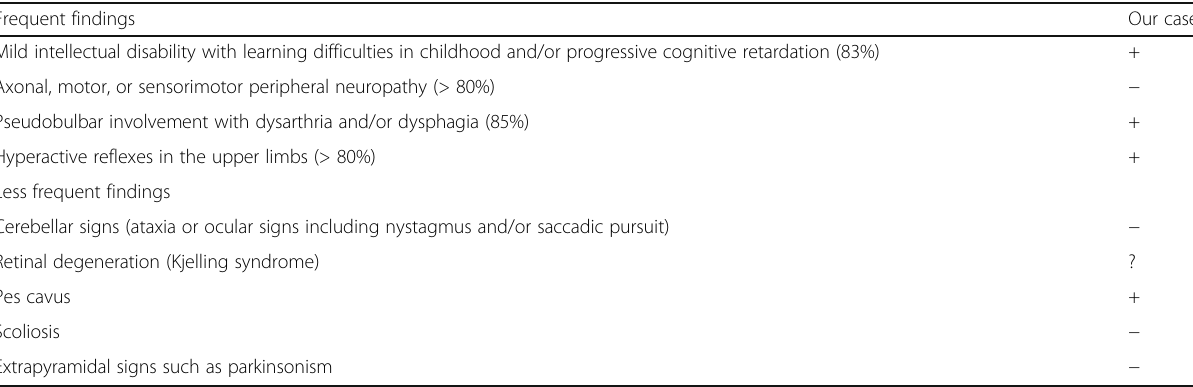
Table 1 Clinical findings of SPG 11 and comparison with our case